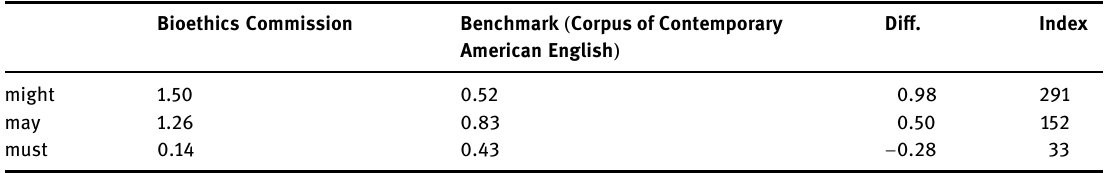
Table 3: Word list extract: frequency of “ might, ” “ may, ” and “ must ” use per 1,000 words ( normalised, n = 1,000 ) by com - mission members, compared to benchmark